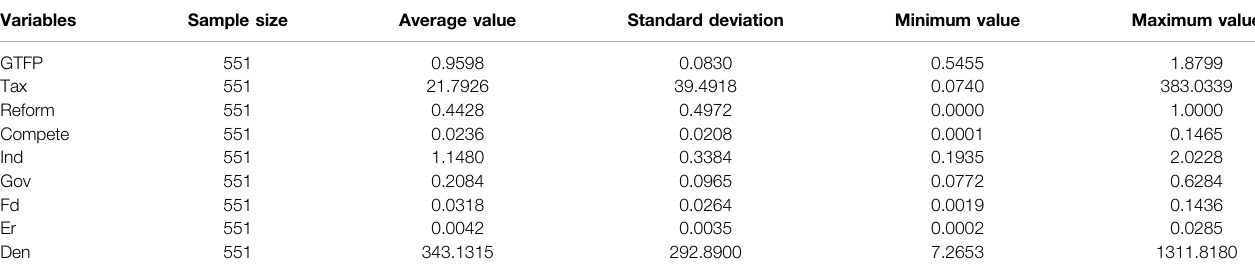
TABLE 1 | Descriptive statistical characteristics of variables.